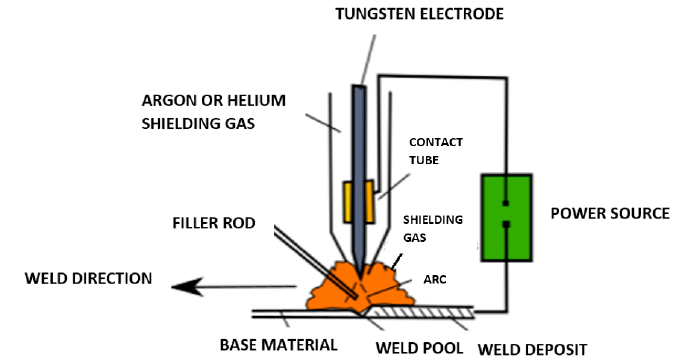
Figure 2. Schematic diagram of tungsten inert gas (TIG) welding incorporated with a filler rod.